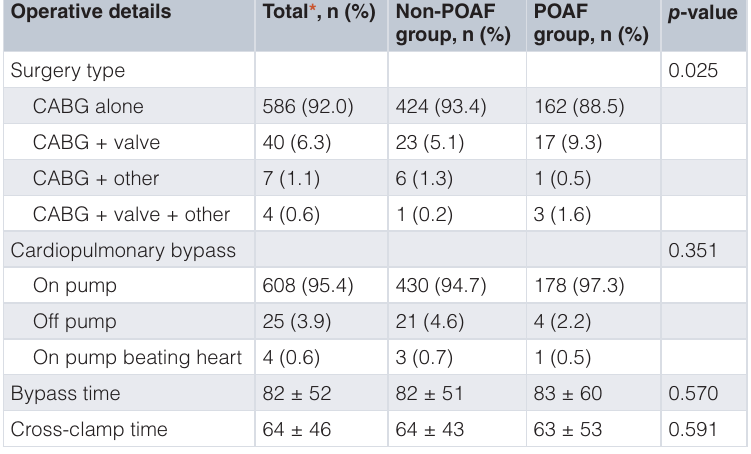
Table 6. Association between post-operative atrial fibrillation (POAF) and patient operative details. CABG, coronary bypass grafting. Operative